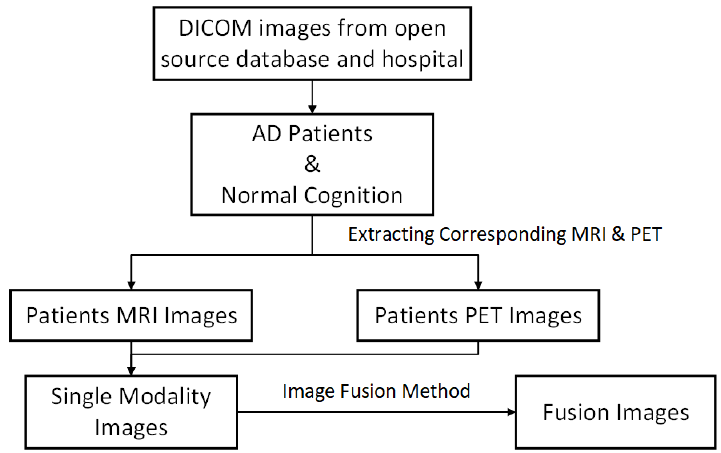
Figure 15. Constitution of the implemented